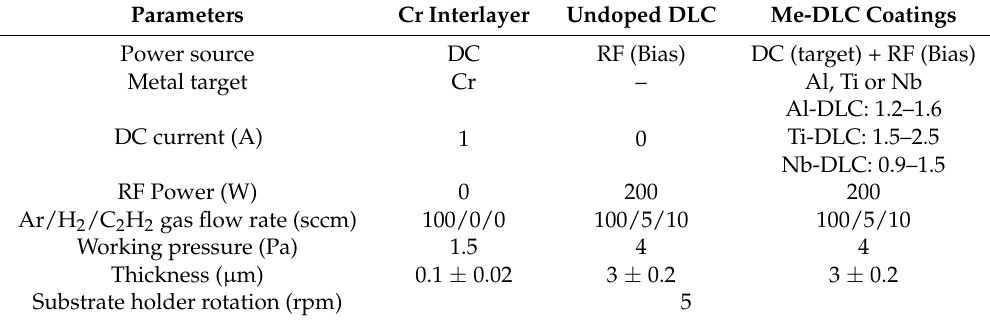
Table 1. Deposition parameters of metal-containing hydrogenated diamond-like carbon coatings (Me-DLC)